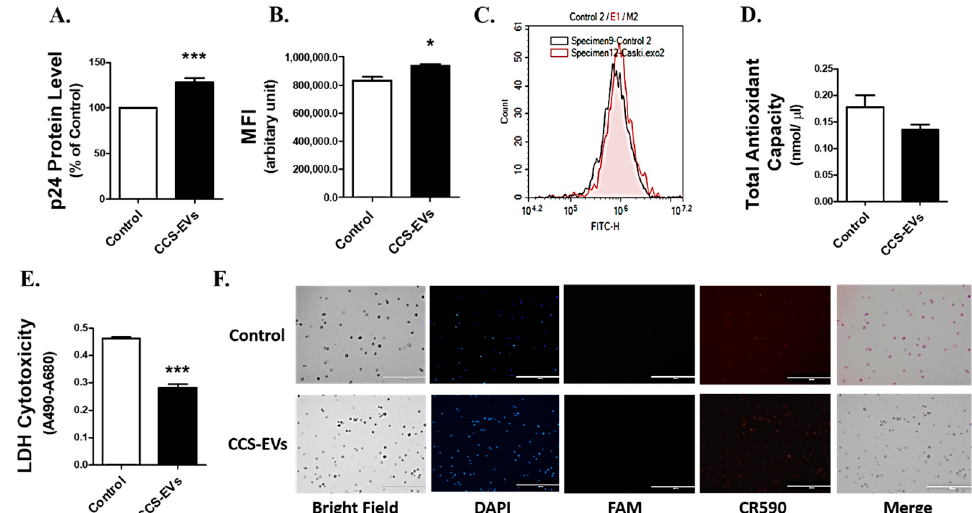
Figure 6. CCS-derived EVs (CCS-EVs) increase HIV-1 replication and oxidative stress in di ff erentiated U1 cell line. ( A ) Di ff erentiated U1 cell line was exposed with EVs derived from 1 mL of CCS (~42 µ g of EVs protein) for 4 days. p24 ELISA was performed on the supernatant obtained from the treatment to measure the viral load. To minimize high standard deviation of the mean due to variability in absorbance values from di ff erent experiments, we converted the control absorbance values to 100% and normalized the values of treated groups to % of the control. ( B ) ROS was measured in di ff erentiated U1 cell line after the 4 days exposure of CCS-EVs. The treated cells were incubated with H2DCFDA, and the fluorescence was monitored at maximum excitation and emission spectra of 495 nm and 529 nm, respectively, using flow cytometry. ( C ) Shows the graphical representation of ROS increase in CCS-EVs-treated U1 cells (red graph) versus control cells (grey graph). The X-axis represents mean fluorescence intensity (MFI), showing ROS level. ( D ) Total antioxidant capacity of the cells was measured in CCS-treated cells using the Total Antioxidant Capacity Assay Kit. The values on the Y-axis represent the total amount of reduced Cu + in nmol / µ L, which quantitatively gives the measure of antioxidant capacity of the cells. ( E ) Cytotoxicity after CCS exposure was measured using the Pierce TM LDH Cytotoxicity Assay Kit. The values on the Y-axis represent the absorbance values of formazan dye at 490 nm, which give the measure of cytotoxicity. The mean absorbance is obtained by subtracting the background absorbance at 680 nm. All the data were obtained from the mean of at least three independent experiments with the error bars representing the standard error of mean. Significant di ff erences * and *** represent p < 0.05 and p < 0.0005, respectively. ( F ) Apoptotic DNA damage was examined using Apoptag ® Iso Dual Fluorescence Apoptosis Detection kit. DAPI, FAM, and CR590 dyes were used to stain the nucleus, DNase Type II and I DNA breaks,